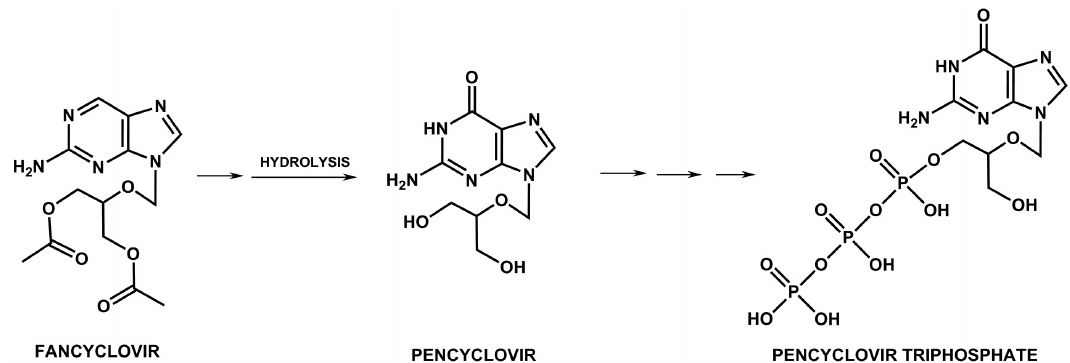
FIGURE 15 - The bioactivation pathway of